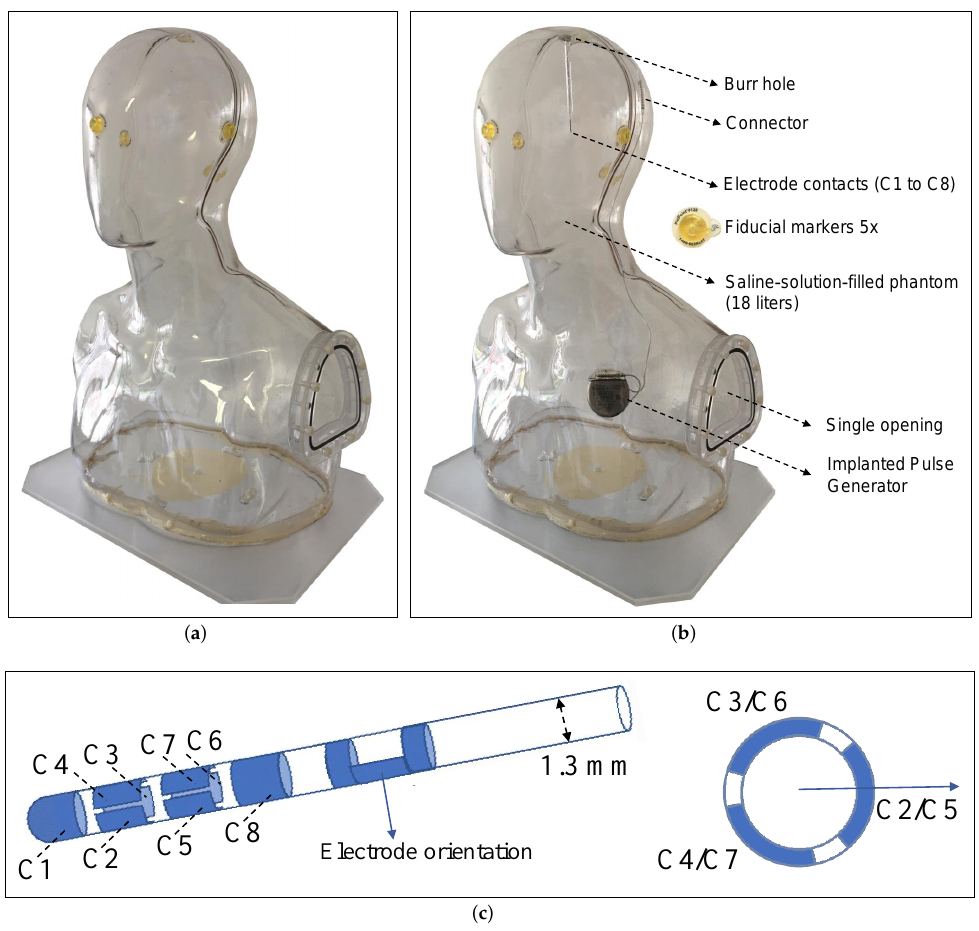
Figure 2. ( a ) Phantom with five fiducial markers attached to the surface of the phantom’s head before DBS intervention. ( b ) Phantom with integrated DBS system consisting of a directional electrode, extension, and Implanted Pulse Generator. ( c ) Directional electrode in side view (left) and bottom view (right), showing the eight numbered contacts (C1–C8), and how the middle two contact levels are divided into three equally spaced segments. The arrow indicates electrode